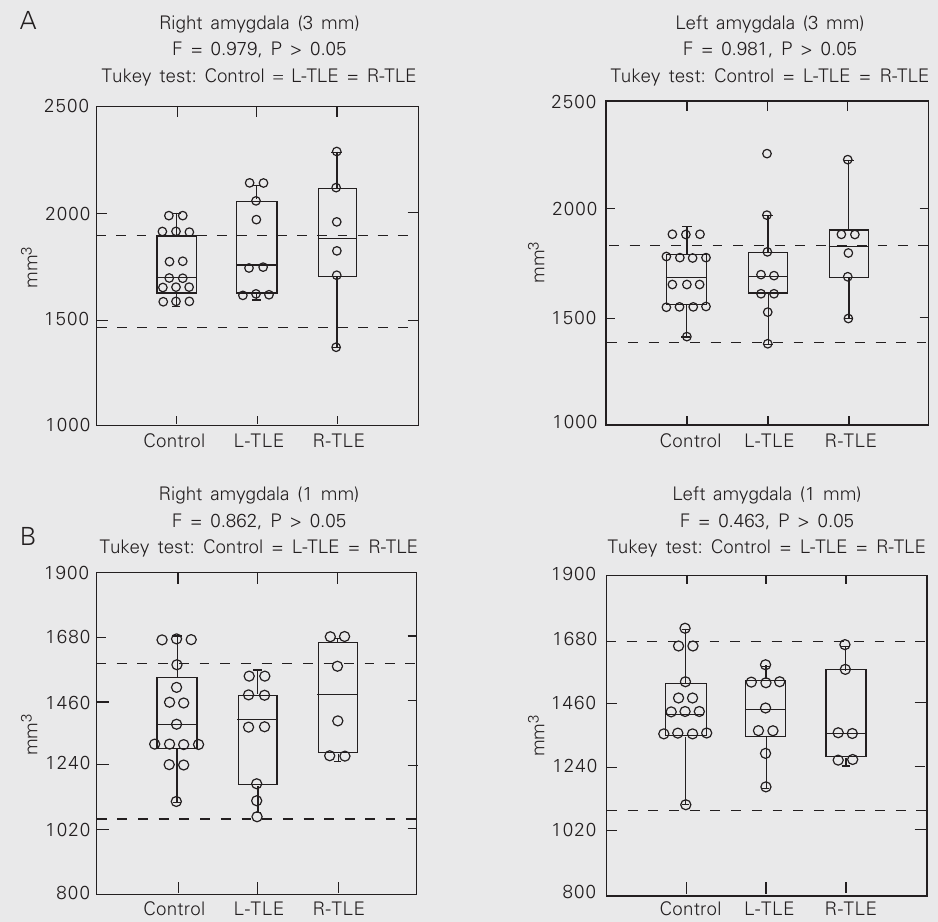
2. Box and whisker plots of the volumes of the right and left amygdala of control sub- jects (A) and patients with TLE (B), for each method of seg- mentation. 3 mm = coronal plane-based analysis; 1 mm = multiplanar analysis; L-TLE, R- TLE = left and right temporal lobe epilepsy,